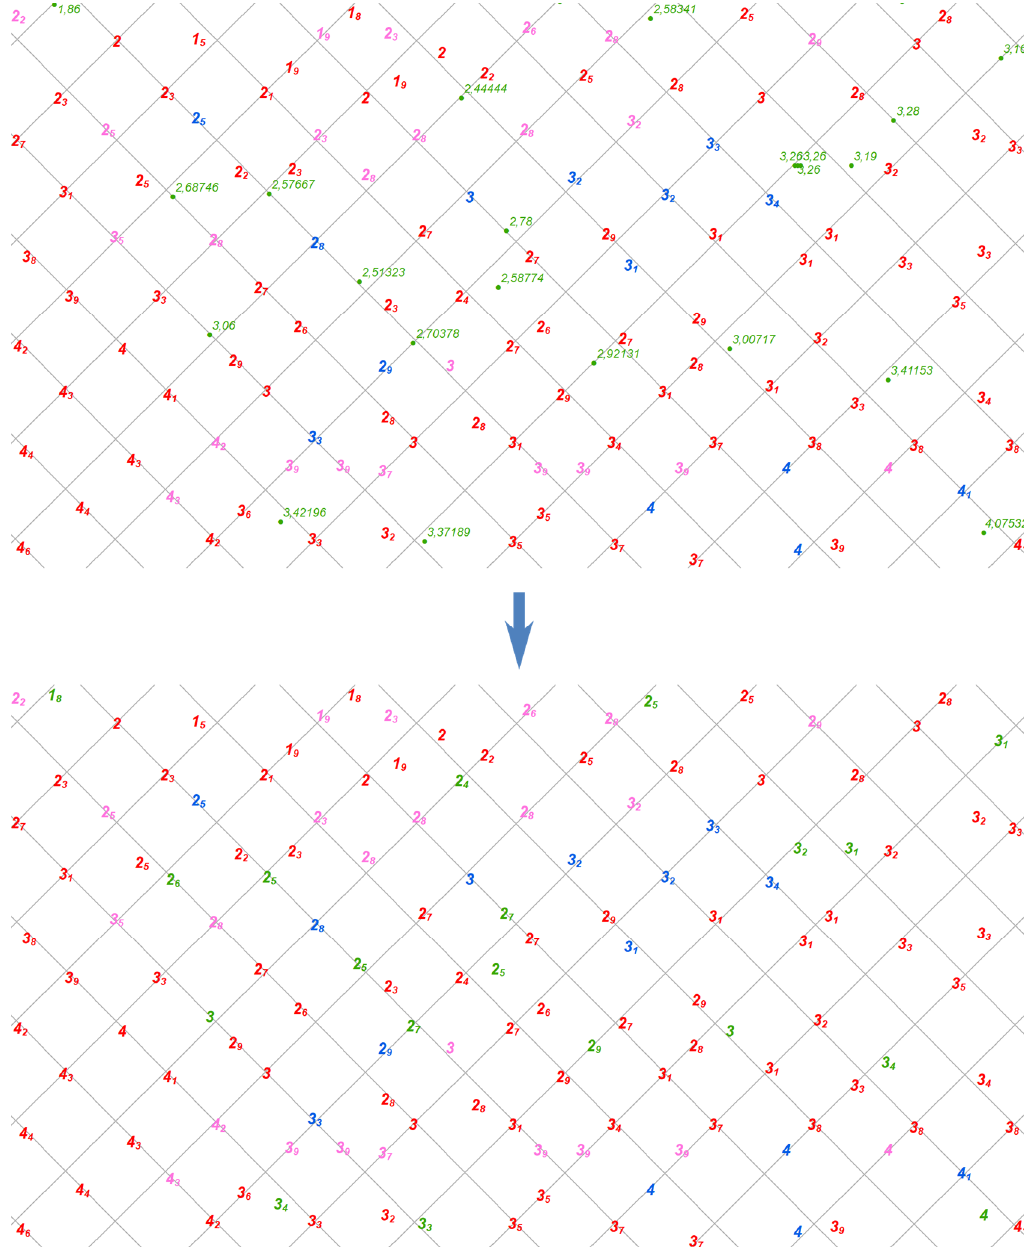
Figure 5. Fill shoal soundings selection (green—Fill shoals, pink—Prime deeps, red—Prime shoals, blue—Background): (top image) selected soundings based on shoal criteria and (bottom image) retained soundings based on distance criteria.